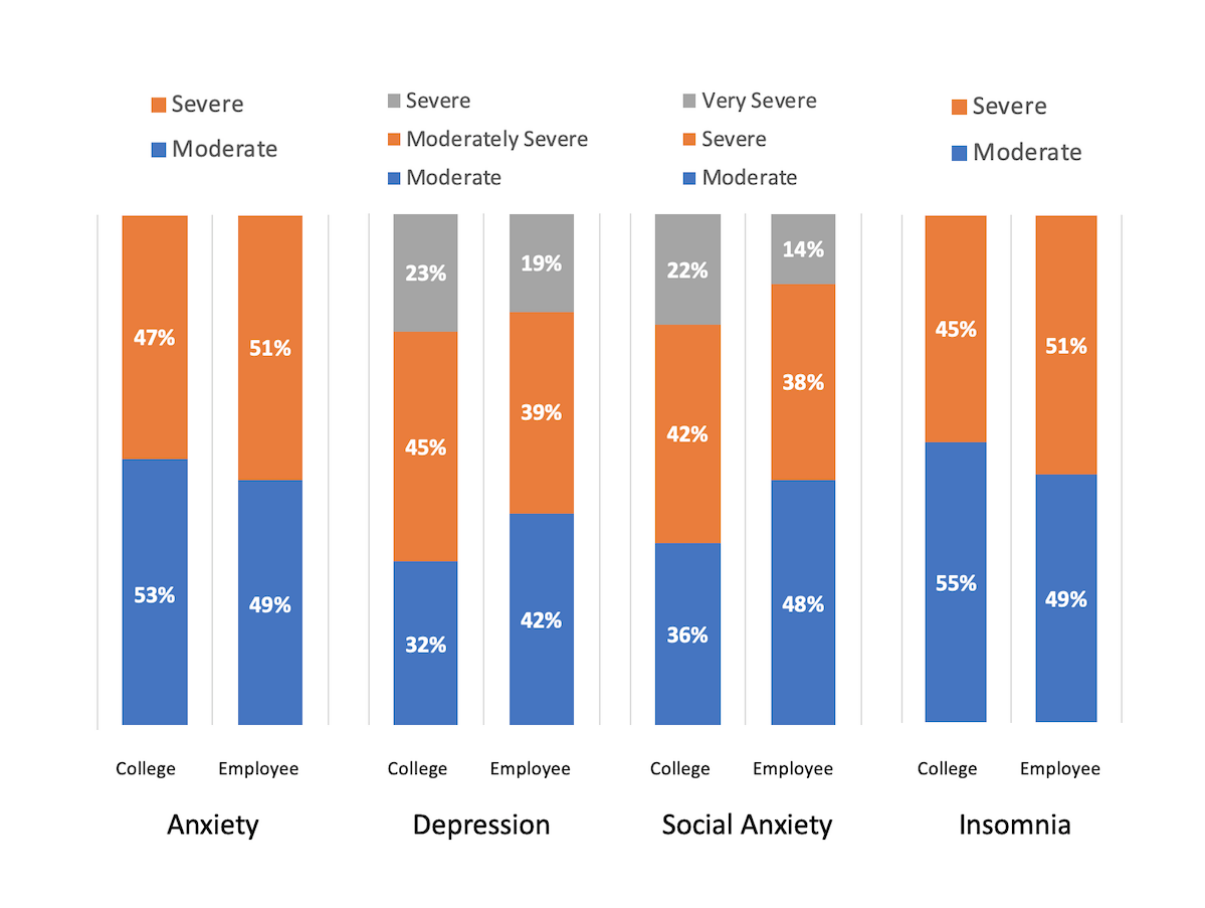
Figure 2. Comparison of percentage of college users and employee users of the same internet-based cognitive behavioral therapy programs at different levels of symptom severity at pre: by clinical assessment measure specific to each